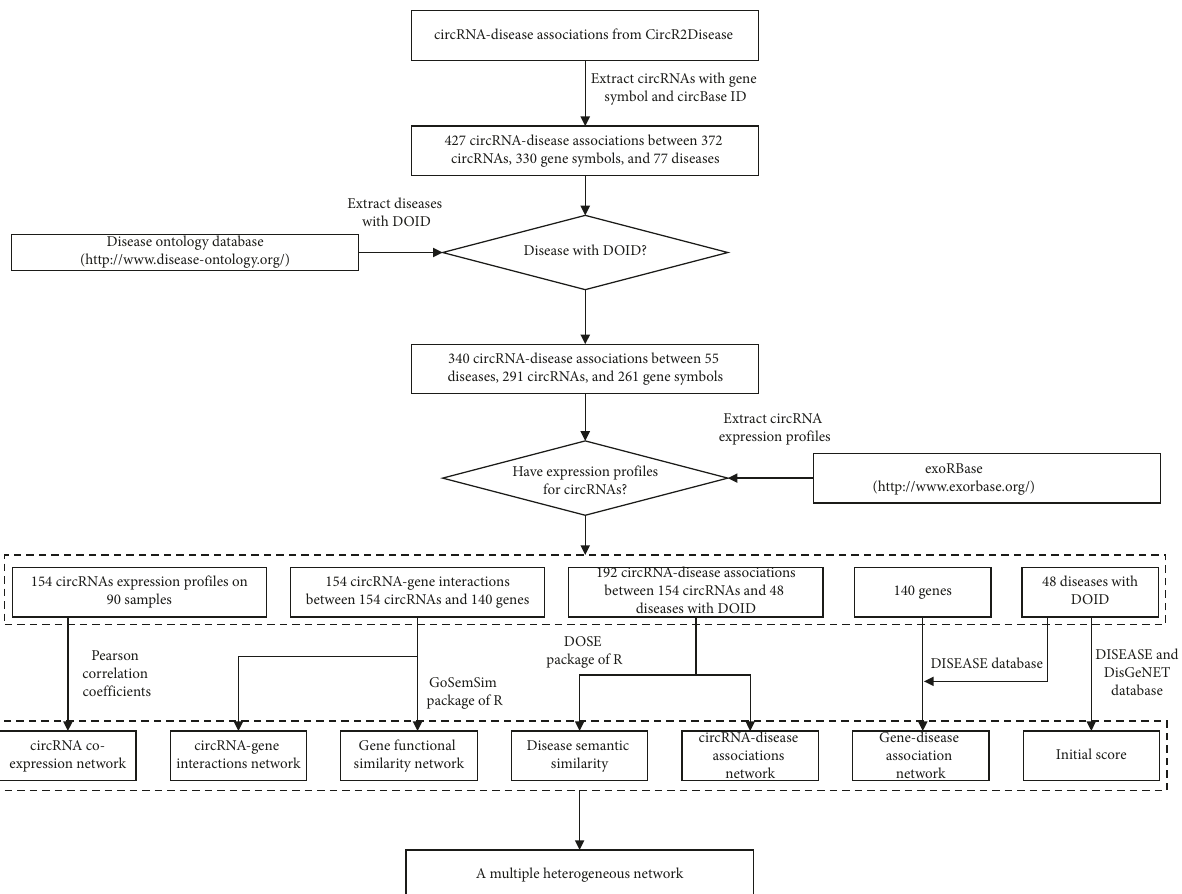
Figure 3: The framework of materials and